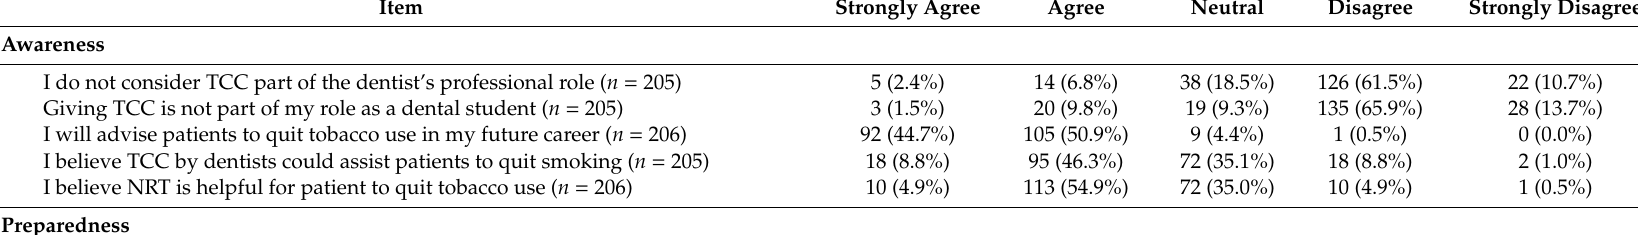
Table 2. Dental students’ awareness, preparedness and perceived barriers towards practicing tobacco cessation counselling (TCC). NRT = nicotine replacement therapy. Item Strongly Agree Agree Neutral Disagree Strongly